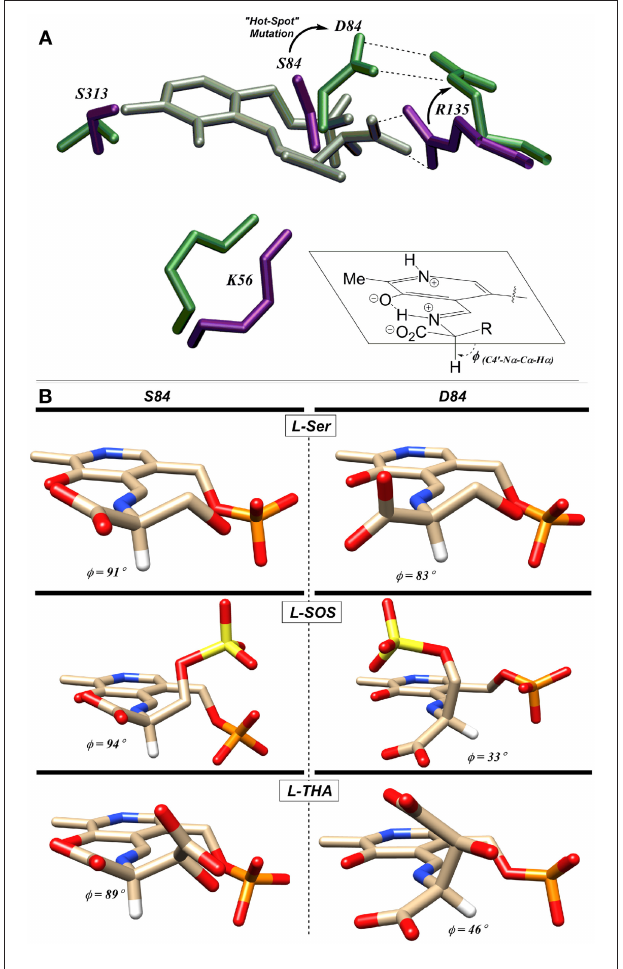
FIGURE 8 | (A) L-THA-derived external aldimine (gray) docked with native-hSR (violet) and S84D hSR (green). The putative L-THA-R135 salt bridge is replaced with a D84-R135 salt bridge in the mutant. (B) Docked external aldimines of L-Ser, L-SOS, and L-THA exhibiting much better Dunathan alignment in wt-hSR (left) than in S84D-hSR (right) [Figure adapted with permission of the American Society for Biochemistry and Molecular Biology (ASBMB) (Schell, 2004; Nelson et al., 2017)].